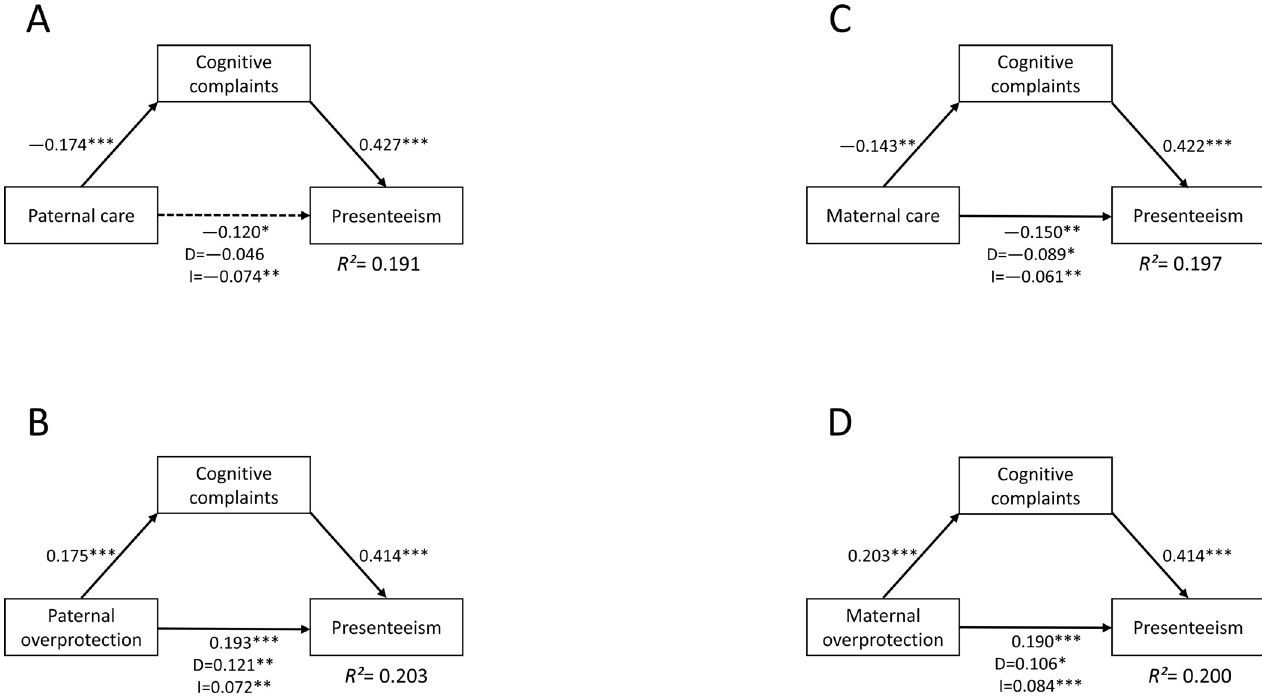
Fig 1. The mediating effect of cognitive complaints on the relationship between childhood parental bonding and presenteeism in adult workers (N = 440). D, direct effect; I, indirect effect; R 2 , coefficient of determination. Relationships between childhood parental bonding, CCs, and presenteeism are demonstrated using path analyses. A) CCs fully mediated the impact of paternal care on presenteeism. B) CCs partially mediated the impact of paternal overprotection on presenteeism. C) CCs partially mediated the impact of maternal care on presenteeism. D) CCs partially mediated the impact of maternal overprotection on presenteeism. The numbers beside the arrows demonstrate the standardized path coefficients of total effects. The numbers below the total effect of parental bonding on presenteeism demonstrate the direct (D) and indirect (I) effects. The solid line demonstrates a significant direct effect, and the dotted line demonstrates a non-significant direct effect. Parental bonding demonstrates PBI sub-scores; CCs demonstrate COBRA total score; and presenteeism demonstrates WLQ work productivity loss score.